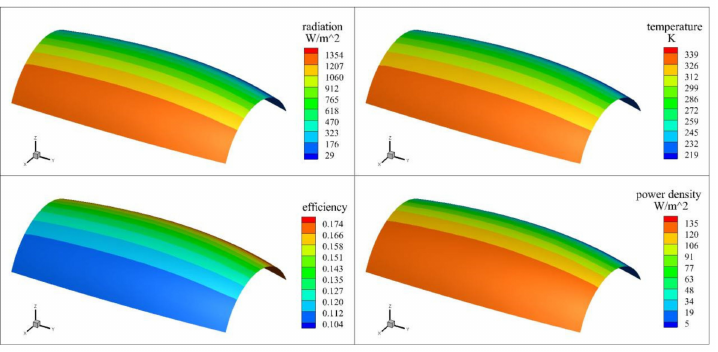
Figure 8. Thermal and energy characteristics of the solar array on the winter solstice at 12:00.